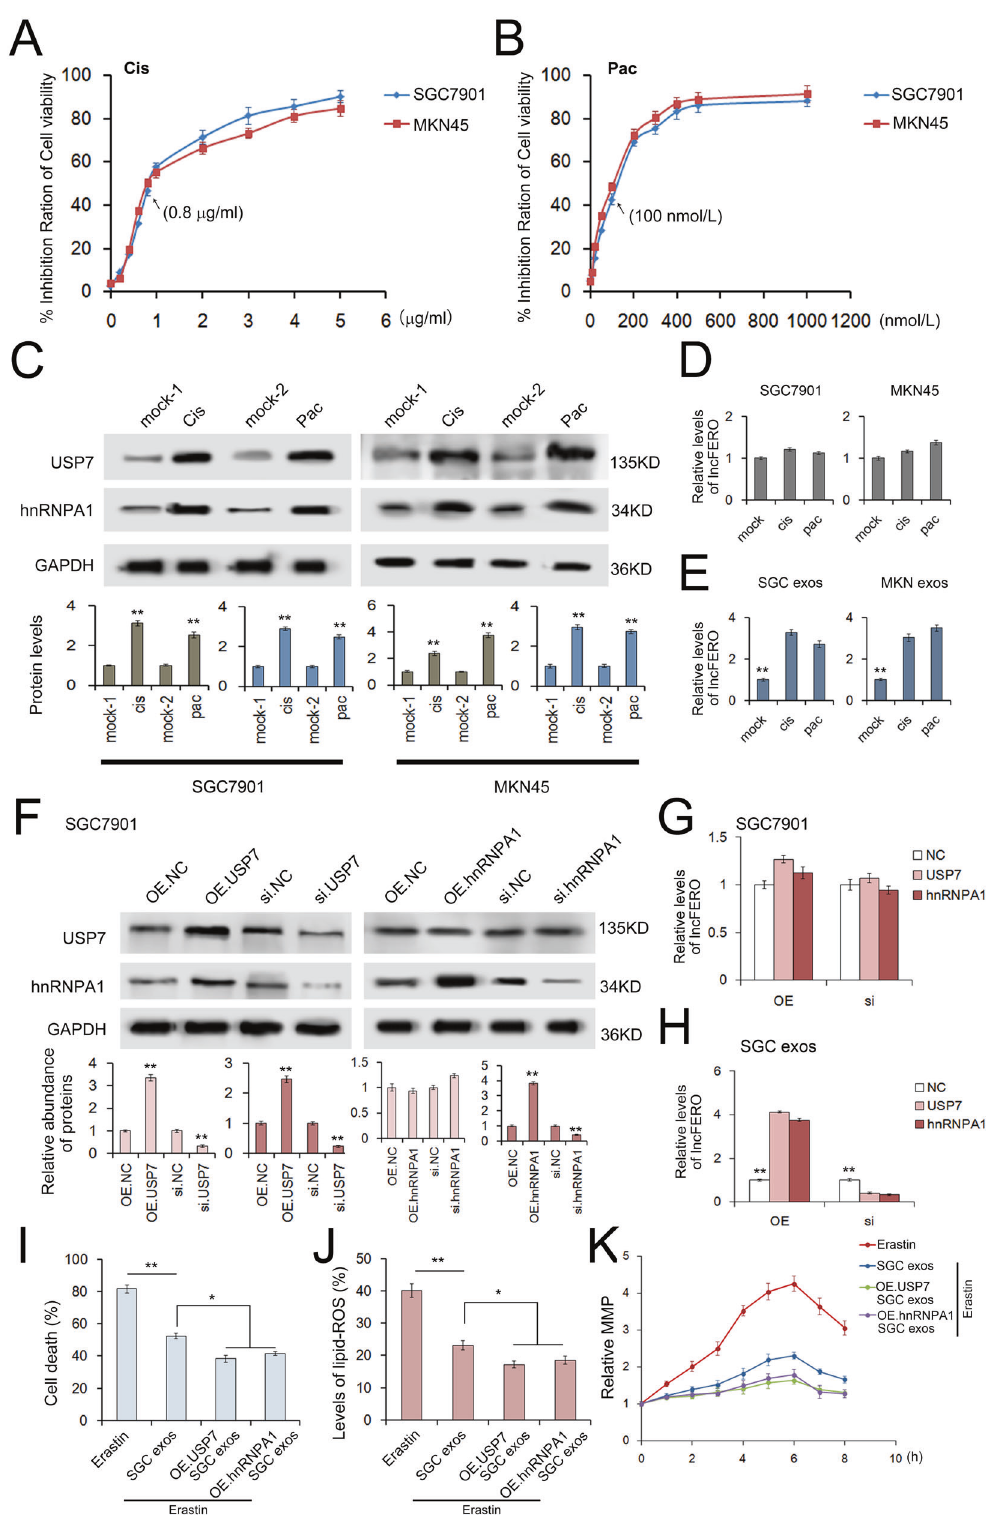
Fig. 7 Chemotoxicity promotes lncFERO secretion from GC cells via the USP7/hnRNPA1 axis. A , B The effects of gradient doses of cisplatin ( A ) and paclitaxel ( B ) on the viability of SGC7901 and MKN45 cells ( n = 3). C The expression of USP7 and hnRNPA1 in GC cells treated with sublethal doses of cisplatin (0.8 μ g/mL) and paclitaxel (100 nmol/L) ( n = 3). D Effects of cisplatin and paclitaxel on the expression of lncFERO in GC cells ( n = 3). E Effects of cisplatin and paclitaxel on the secretion of lncFERO in GC exos ( n = 3). F WB analysis of USP7 and hnRNPA1 in SGC7901 cells treated with corresponding overexpression plasmids or siRNAs ( n = 3). G Effects of USP7 and hnRNPA1 on the expression of lncFERO in SGC7901 cells ( n = 3). H Effects of USP7 and hnRNPA1 on the expression of lncFERO in SGC exos ( n = 3). I – K Exosomes derived from SGC7901 cells overexpressing USP7 and hnRNPA1 suppressed erastin-induced cell death ( I ), lipid ROS production ( J ), and the MMP increase ( K ) in GCSCs ( n = 3). * p < 0.05 and ** p < 0.01. Cell Death and Disease (2021)